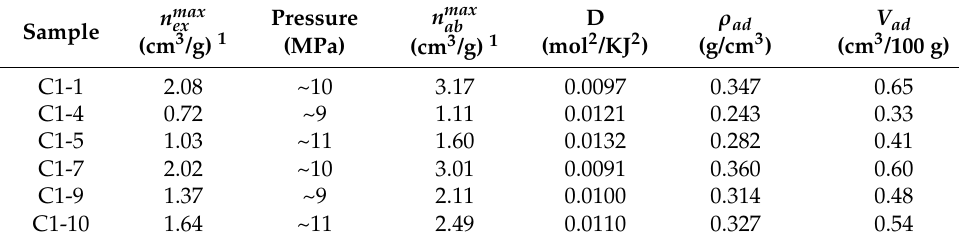
Figure 2. Measured and fitted methane excess adsorption isotherms ( a ) and calculated absolute adsorption isotherms using the SDR model ( b ) for the studied Permian samples at 60 °C. Table 2. Adsorption parameters of the studied samples fitted by SDR model at 60 °C.